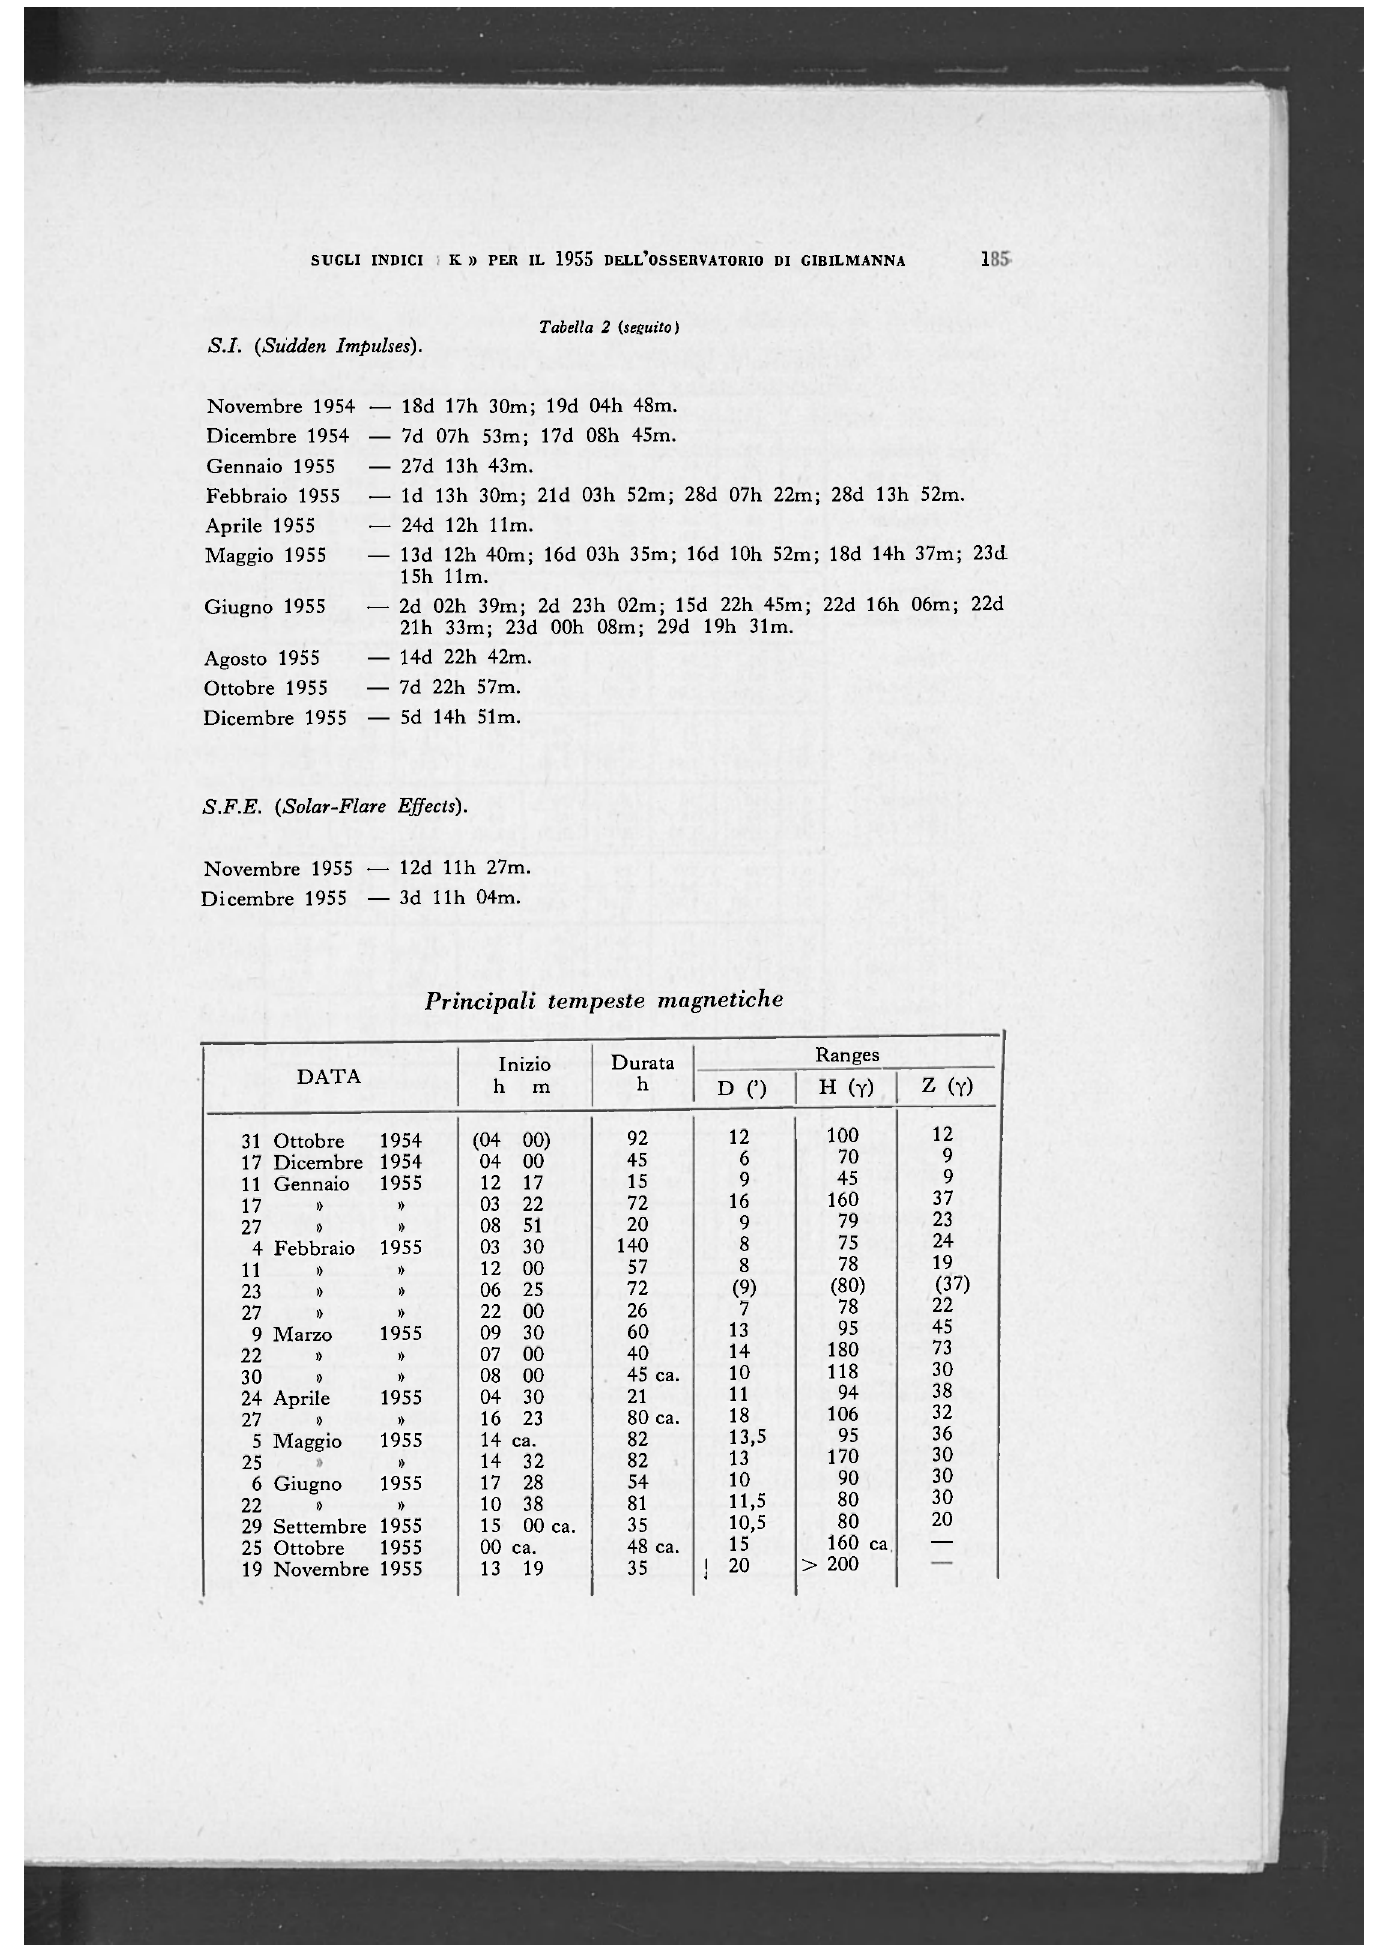
Tabella 2 (seguito)